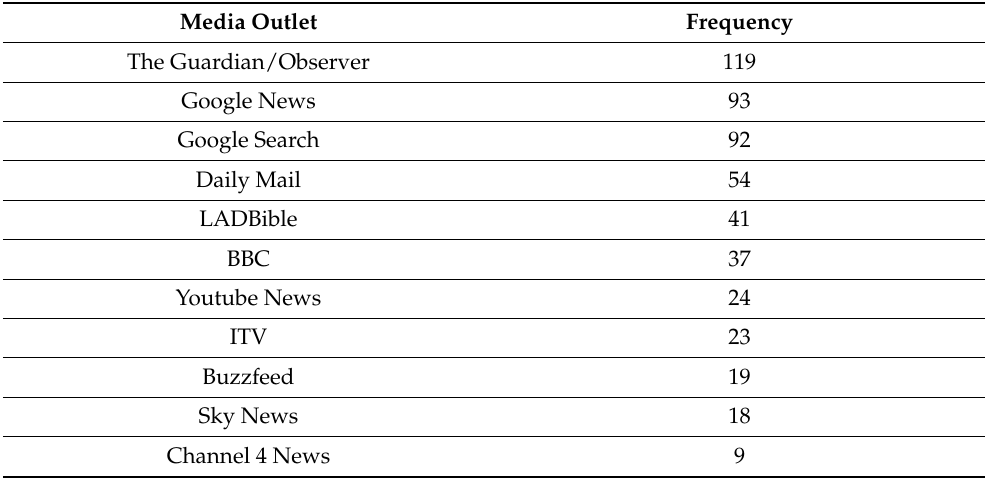
Table 1. Newspaper Frequency